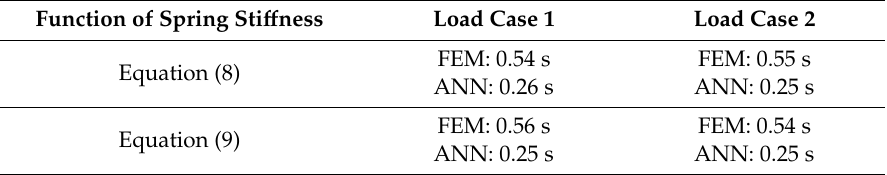
Table 2. Simulation times comparison—example